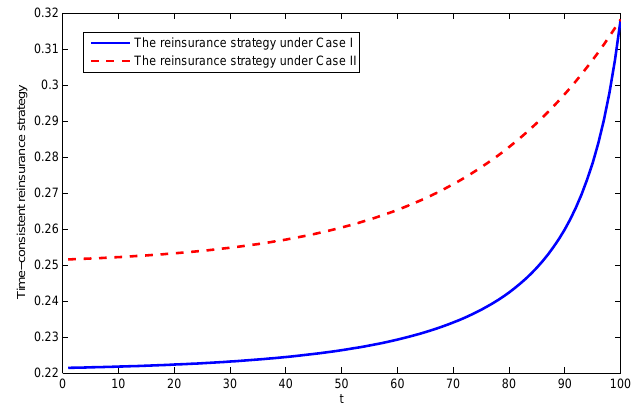
Figure 9. Time-consistent reinsurance strategy under the variance value principle ( α = 0.4 and T = 100).